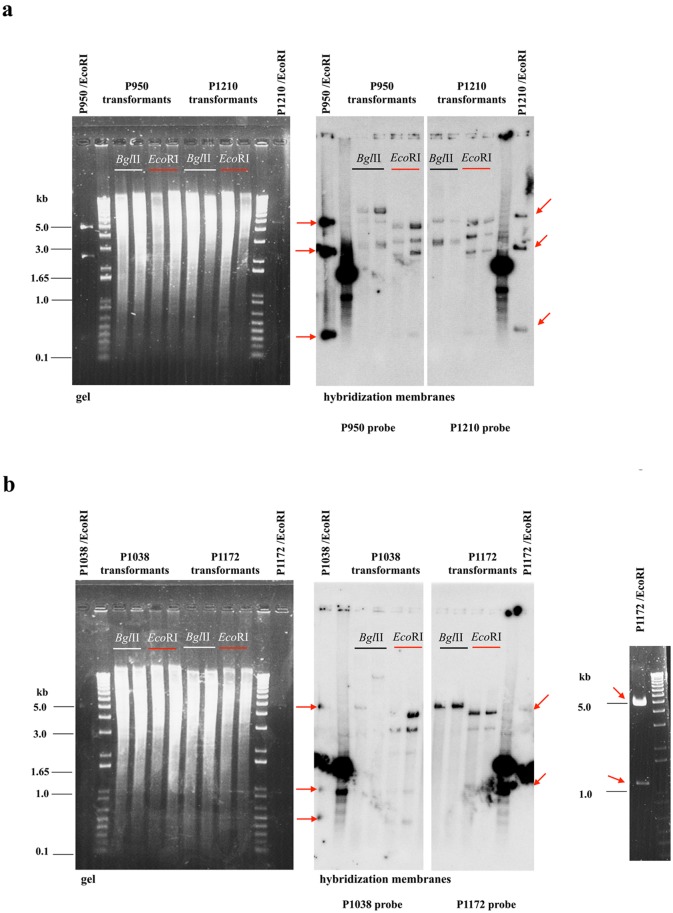
Southern hybridization of the total DNA of the transformants carrying CEN1 or CEN2 plasmids.(a) The gel and hybridization membrane for the CEN2 plasmid transformants P950 and P1210. (b) The gel and hybridization membrane obtained for the CEN2-5 (P1038) and CEN1 (P1172) transformants. The total DNA was digested either with EcoRI (present on the plasmids) or BglII (absent on the plasmids). Digested with EcoRI, the control plasmids were P950 (CEN2 of Y881), P1210 (CEN2 of Y879), P1038 (CEN2-5 deletion plasmid of CEN2) and P1172 (CEN1). Linearized by PstI (P950, P1210 and P1038) or HindIII (P1172) and labeled with [γ-32P] dCTP, the whole plasmid was used as the hybridization probe. In the figure, the EcoRI restriction-fragments of the corresponding plasmids are shown with arrows. As all the plasmids have a pUC57 segment, the probes also hybridized with 1 kb ladder (10787018, Invitrogen, Life Technologies).